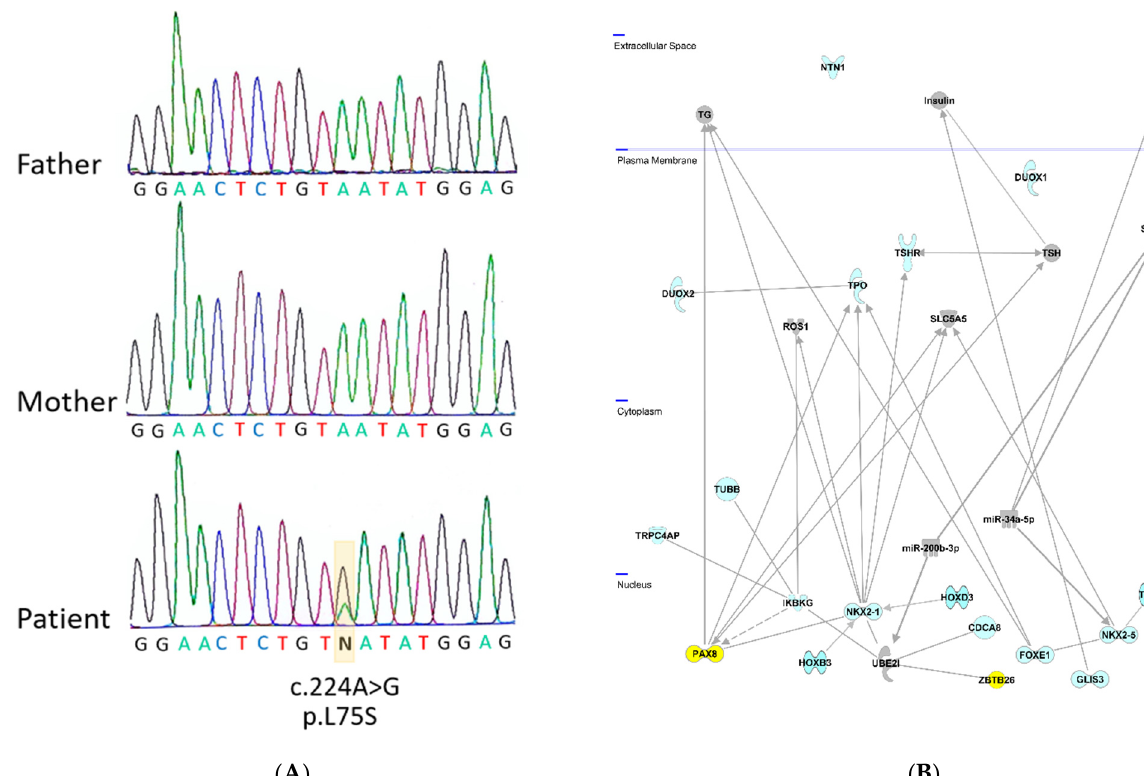
Figure 1. Identified variants in the ZBTB26 gene and IPA Network analysis with known CH genes. ( A ) Sequence of trio with unaffected parents and affected child. Sanger sequencing in index case demonstrates a de novo variant c.224A>G in the ZBTB26 gene which was not present in the unaffected parents. ( B ) Ingenuity (IPA) Network analysis. Known genes from the literature (in blue color) underlying congenital primary hypothyroidism were analyzed using the IPA network analysis. The newly identified ZBTB26 gene was added to predict functional connections in the context of known protein networks. ZBTB26 and PAX8, both located in the nucleus, are highlighted in yellow. They are connected via NKX2-1 and UBEI. BOREALIN is also called CDCA8.